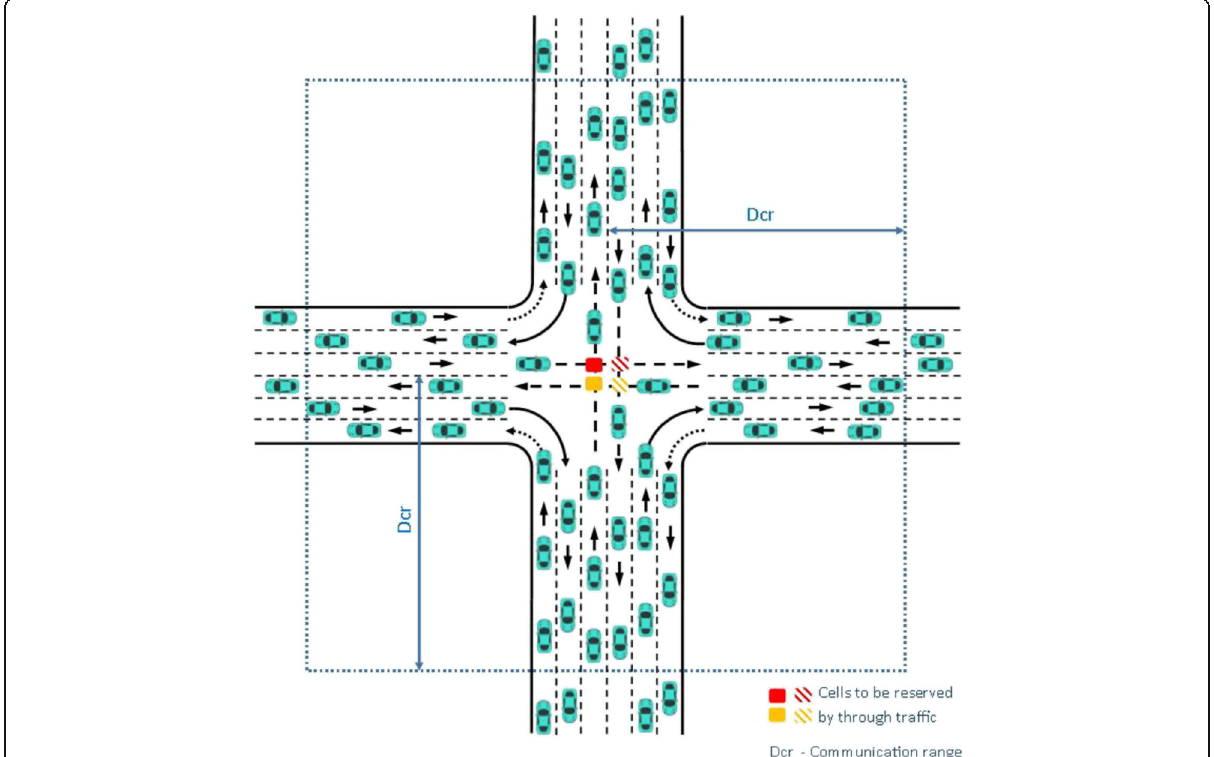
Fig. 1 Lane allocation in CADLARIC control